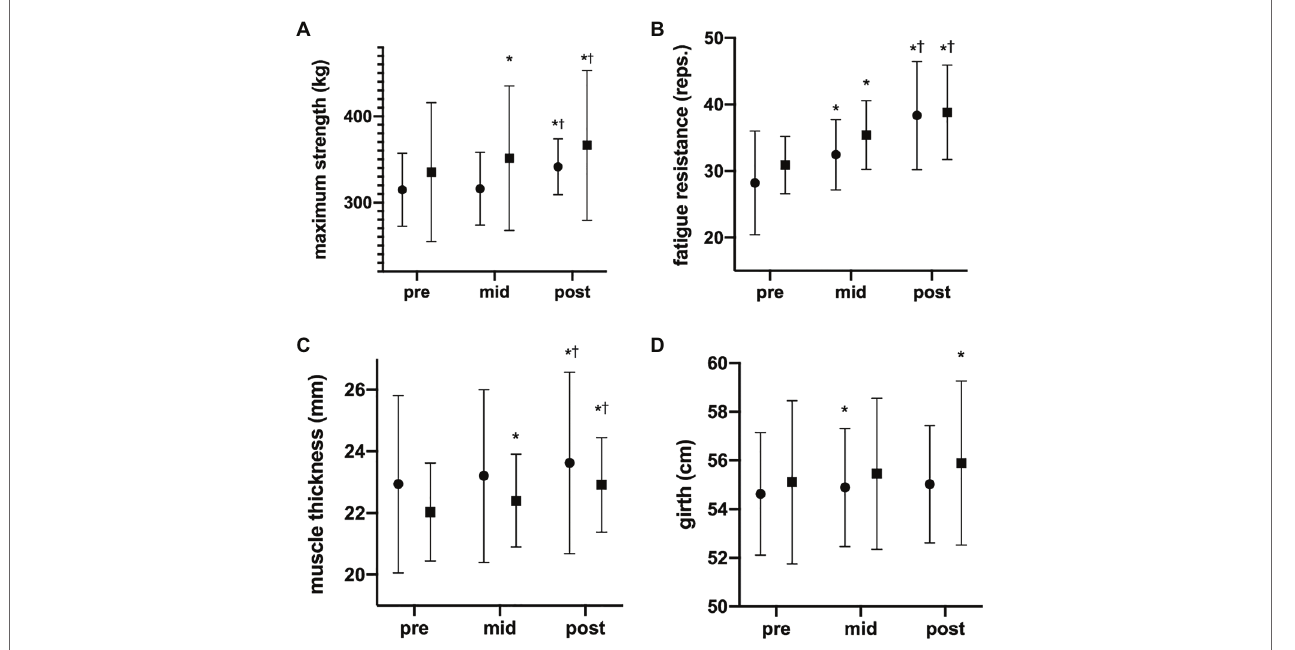
FIGURE 3 | Development of maximum strength, fatigue resistance, muscle thickness, and girth. The data are presented as mean values ± SD. The graphs show (A) 1RM, (B) fatigue resistance, (C) muscle thickness, and (D) girth changes during the 6 weeks of the study (pre = after 0 weeks, mid = after 3 weeks, and post = after 6 weeks). [*] = statistically significant difference to pre-value; • = rBFR, ■ = cBFR. † Significant difference between mid and post.